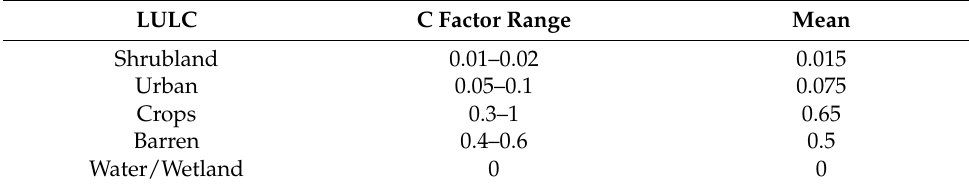
Table 2. The C factor for different land use land cover (LULC) classes. LULC C Factor Range Mean Shrubland 0.01–0.02 0.015 Urban 0.05–0.1 0.075 Crops 0.3–1 0.65 Barren 0.4–0.6 0.5 Water/Wetland 0